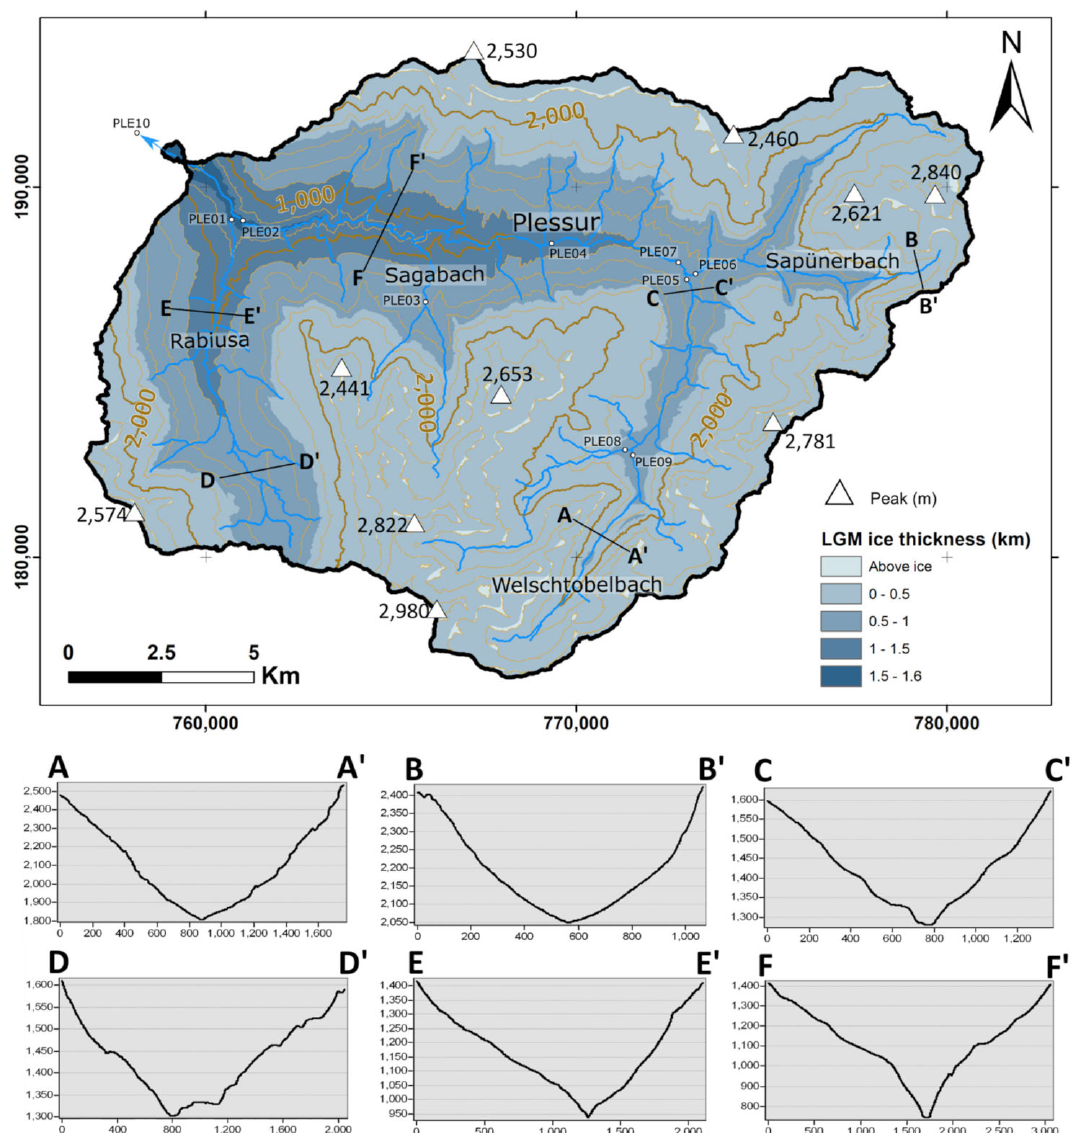
Figure 3. Map of the ice thickness in the Plessur basin during the LGM (from [35]) and main geomorphologic features. The contour lines of the ice thickness map display the elevations of the ice surface in meters above sea level. The map also shows the highest peaks in the study area. The transects from AA’ to FF’ (from up- to downriver) displays an ongoing transformation of an originally U-shaped valley to a V-shaped valley, reflecting the response to more prominent fluvial incision in the lowermost part of the Plessur basin. The numbers at the border of the figure indicate the Swiss coordinates in